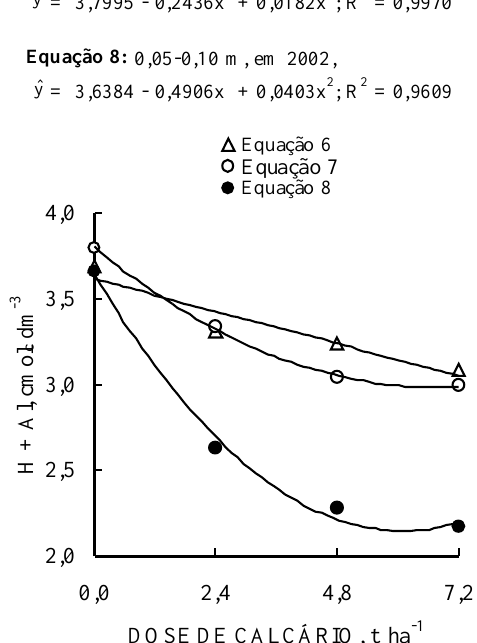
Figura 4. Valores de acidez potencial (H + Al) de acordo com as doses crescentes de calcário distribuído na superfície do solo em 1999. As equações de regressões (linear e quadrática) variam de acordo com as camadas de solo (0,05– 0,10 e 0,10–0,20 m) e anos de amostragem (2000, 2001 e 2002).